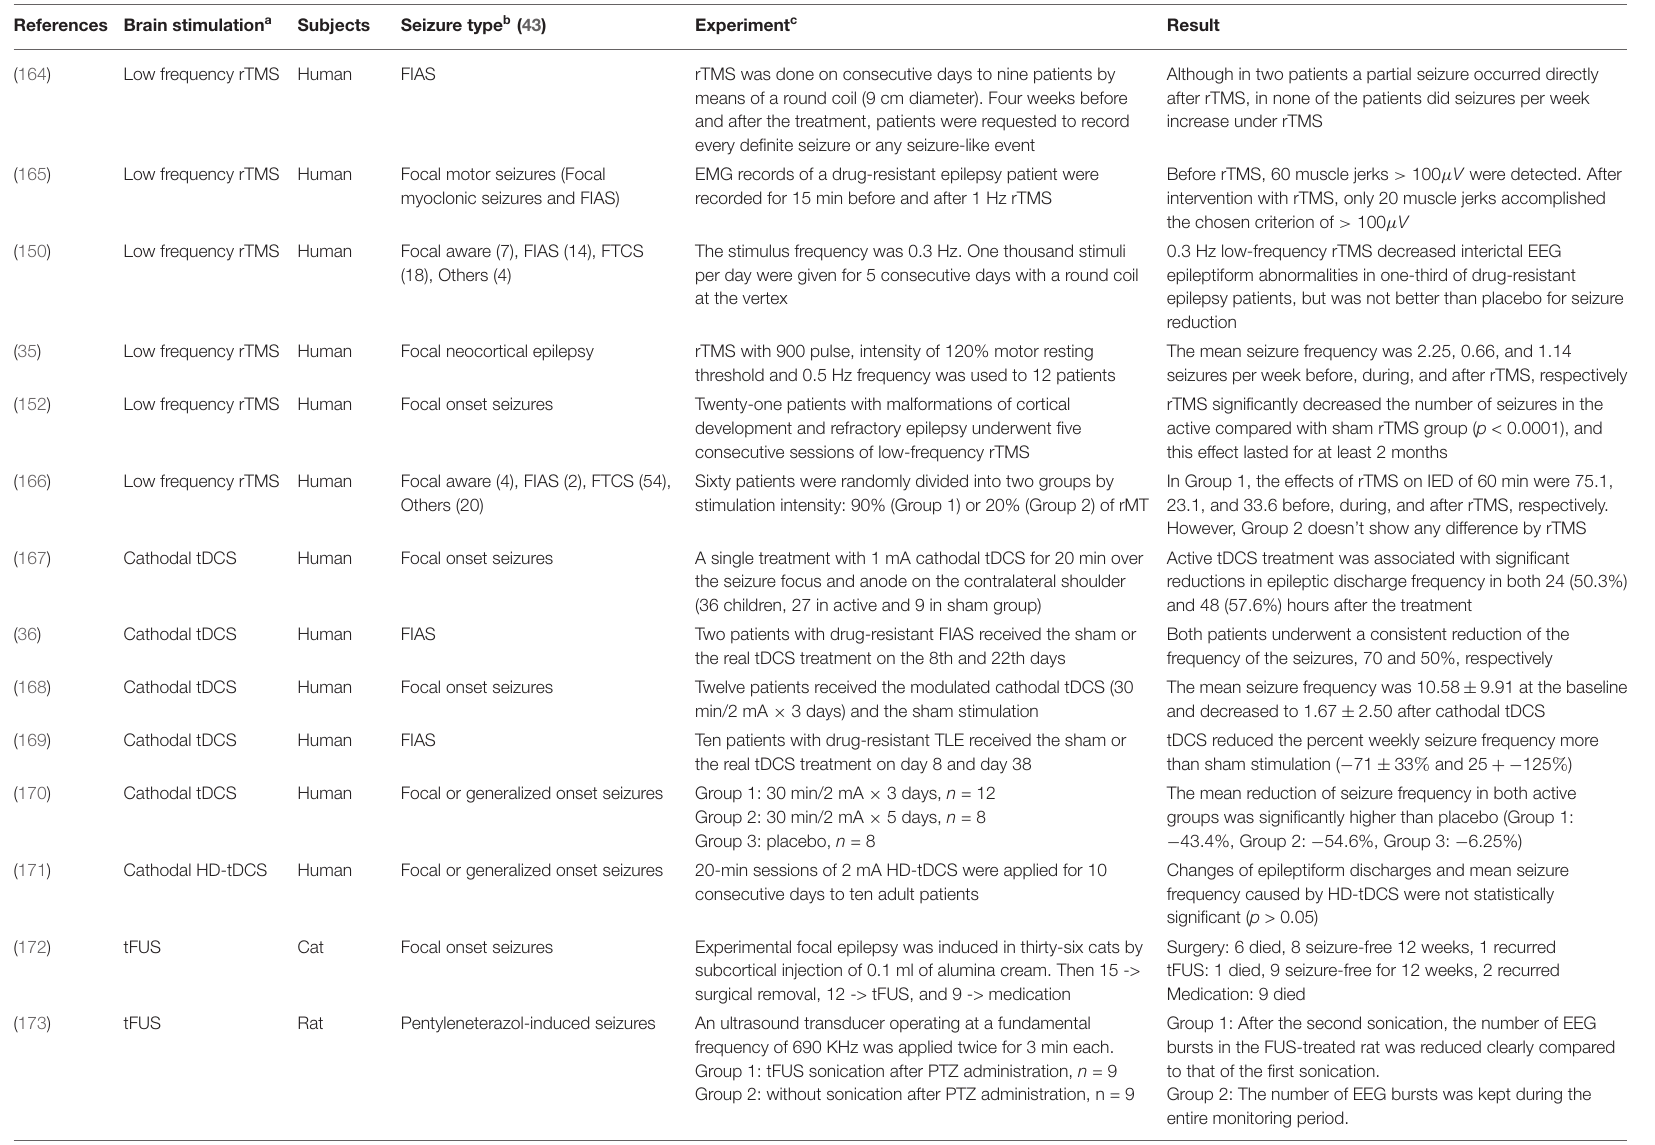
TABLE 3 | Experimental non-invasive neuromodulation treatments for epilepsy [Reviews for readers who want to know more about neuromodulation treatments: (161–163)]. References Brain stimulation a